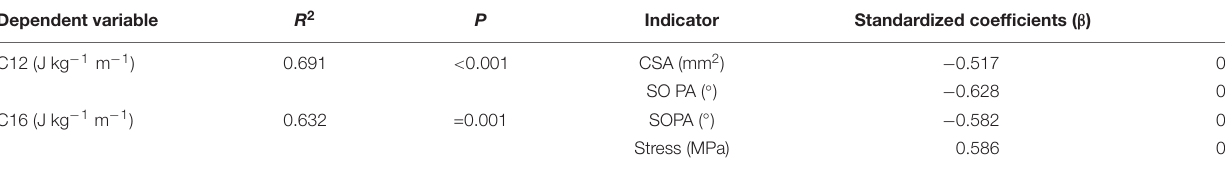
TABLE 3 | Determinants of metabolic cost at 12 km h − 1 (C12) and at 16 km h − 1 (C16) of running on a treadmill. Dependent variable